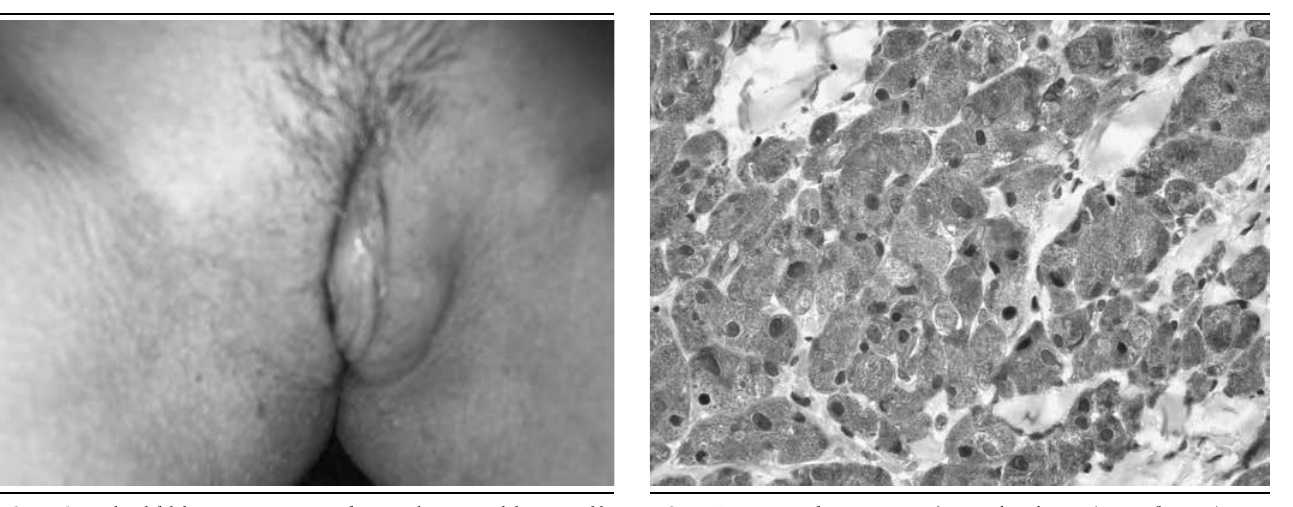
figurE 3 – Positivity for protein S-100 (immunohistochemistry). Magnification 40×